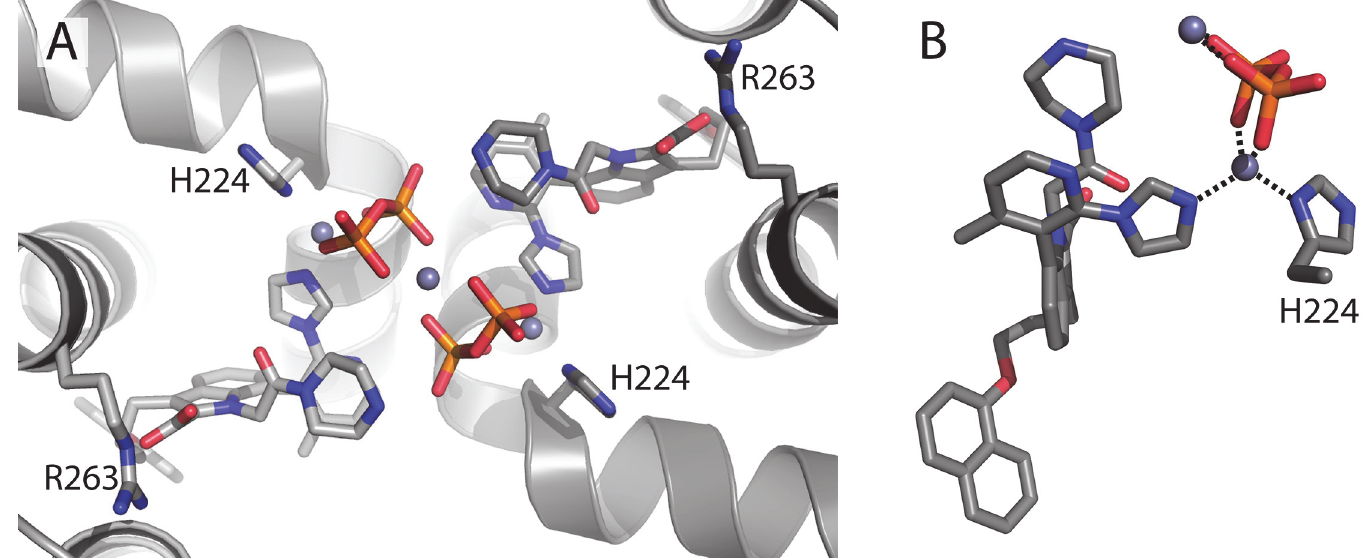
Fig 2. Crystal packing of MCL1 173 – 321 is mediated by zinc and pyrophosphate. (A) The structure of MCL1 173 – 321 was determined to 1.70 Å . (B) In the ligand-bound MCL1 173 – 321 structure, the imidazole group of 1 coordinates with zinc along with H224 and pyrophosphate.